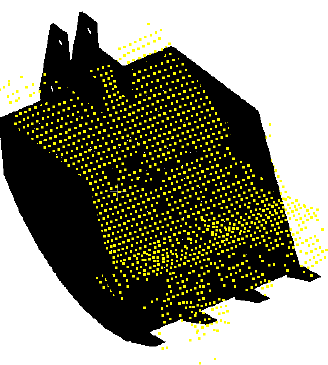
Figure 13. Merging the point cloud for the filled bucket soil volume into one for the CAD Model. For experimental validation, two different scenarios were considered. The first sce- nario (Figure 14a) keeps almost the same amount of incremental volume in each dig while the second scenario (Figure 14b) less uniform increment. As seen in Figure 14, five digs were carried out in both cases and the vertical axis shows the estimation of soil volume that is accumulated according to each dig.